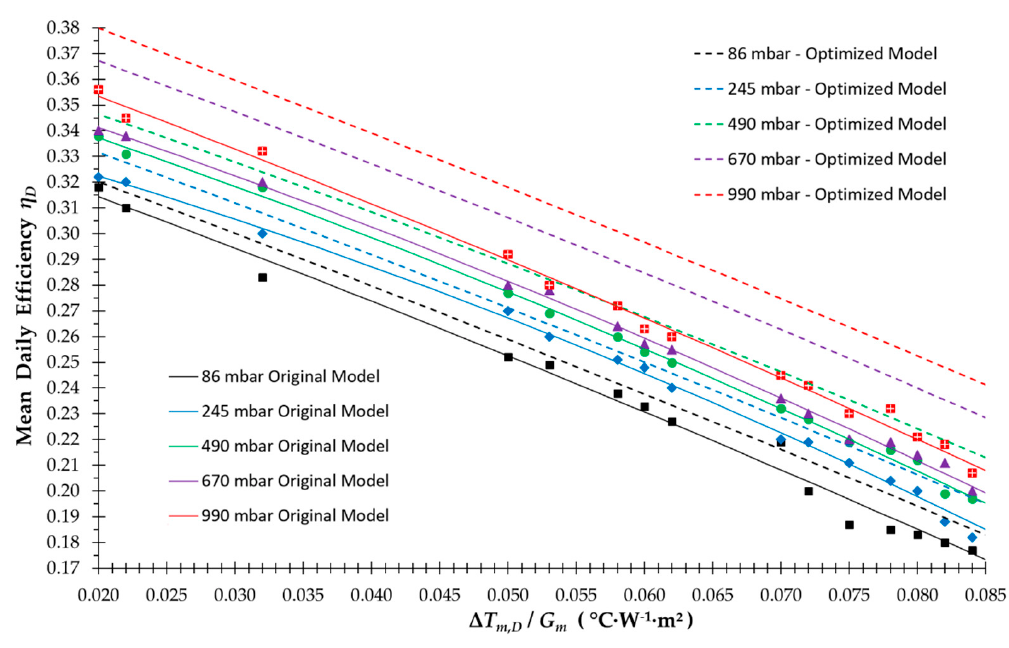
Figure 9. Variation of the mean daily efficiency for the optimized and reference ICS models.